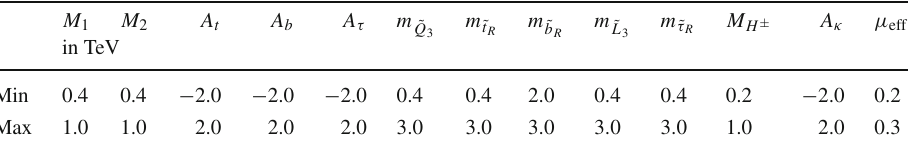
Table 1 Scan ranges for the NMSSM scan. All parameters are varied independently between the given minimum and maximum values, denoted by “min” and “max”,